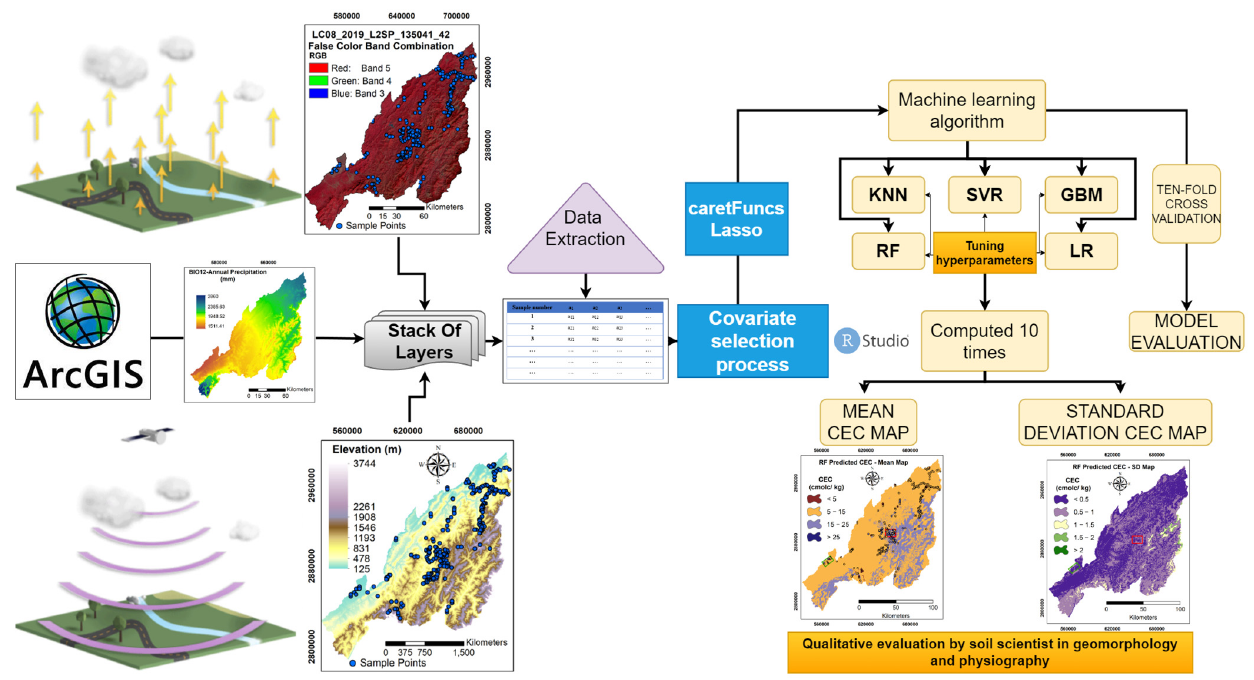
Figure 2. A simpli fi ed fl owchart outlining the research conducted in this study. Figure 2. A simplified flowchart outlining the research conducted in this To reduce the redundancy among digital covariates and to produce a model with a parsimony approach [47], the recursive feature elimination (rfe) process in accordance with root mean square error (RMSE) minimization (Figure A1) was employed while tak-